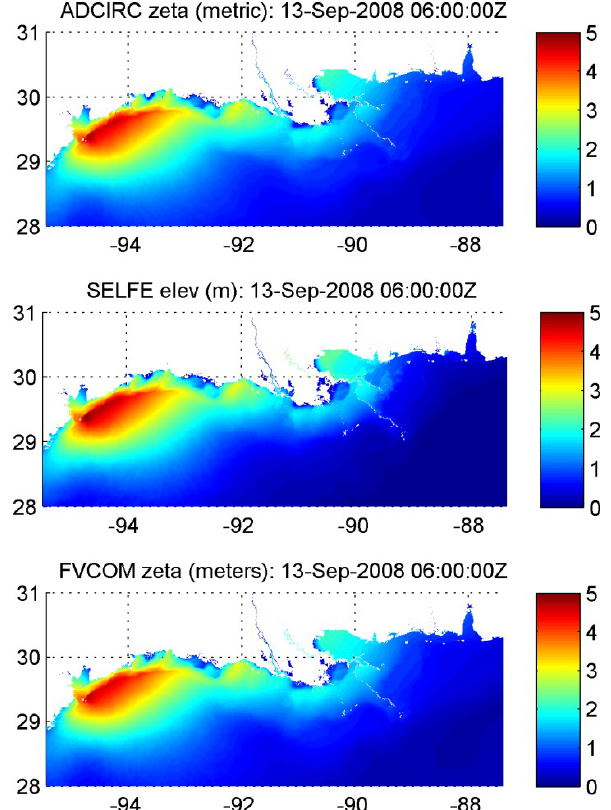
Figure 4. Water levels from three different unstructured grid models (ADCIRC, SELFE and FVCOM) displayed by the NCTOOLBOX script demos/contrib/test_ugrid3.m . The script takes advantage of the UGRID conventions to access and display data from